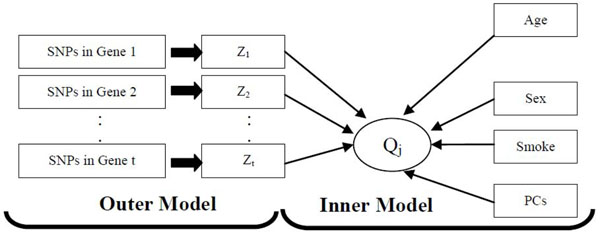
The GBPLS algorithm for Qj (j = 1, 2).